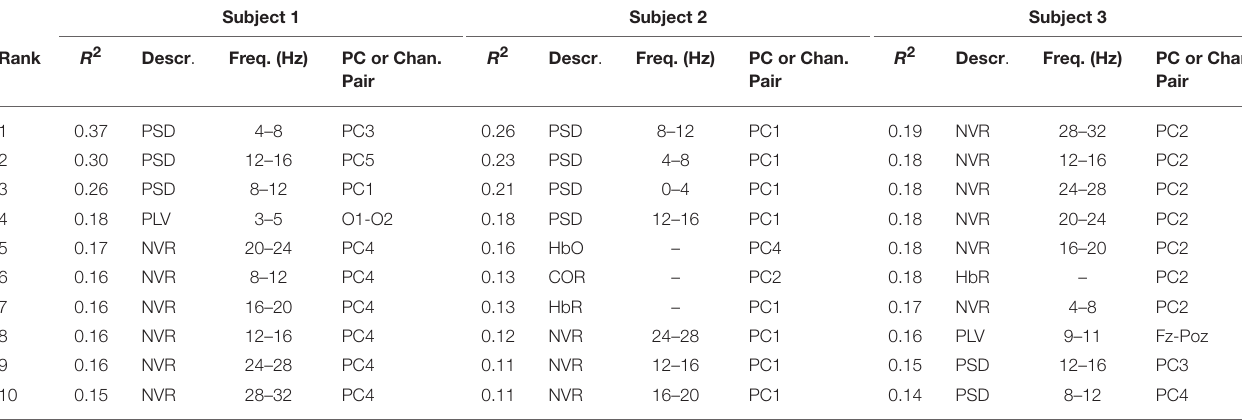
TABLE 1 | The top R 2 ranked features for three representative subjects for the binary rest v 3-back classification.